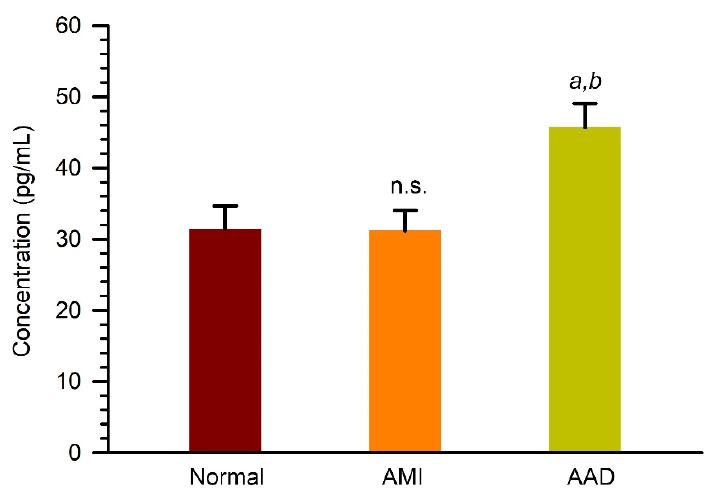
Figure 4. Quantitation of Cadherin-5 (VE-cadherin) in serum samples from normal, AMI, and AAD patients. Serum samples were analyzed by using a quantitative ELISA kit. a and b , p < 0.01 as compared to normal group; p < 0.005 as compared to AMI group. n.s., not significant as compare to normal group.